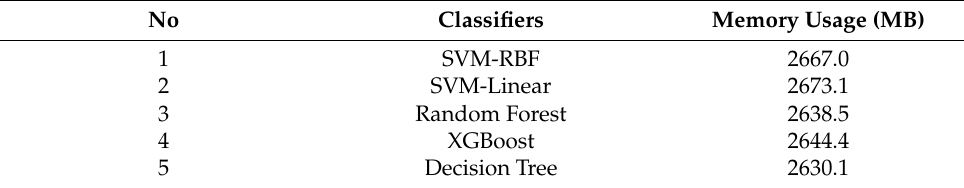
Table 10. Memory utilization of the machine learning classifiers on version 2.